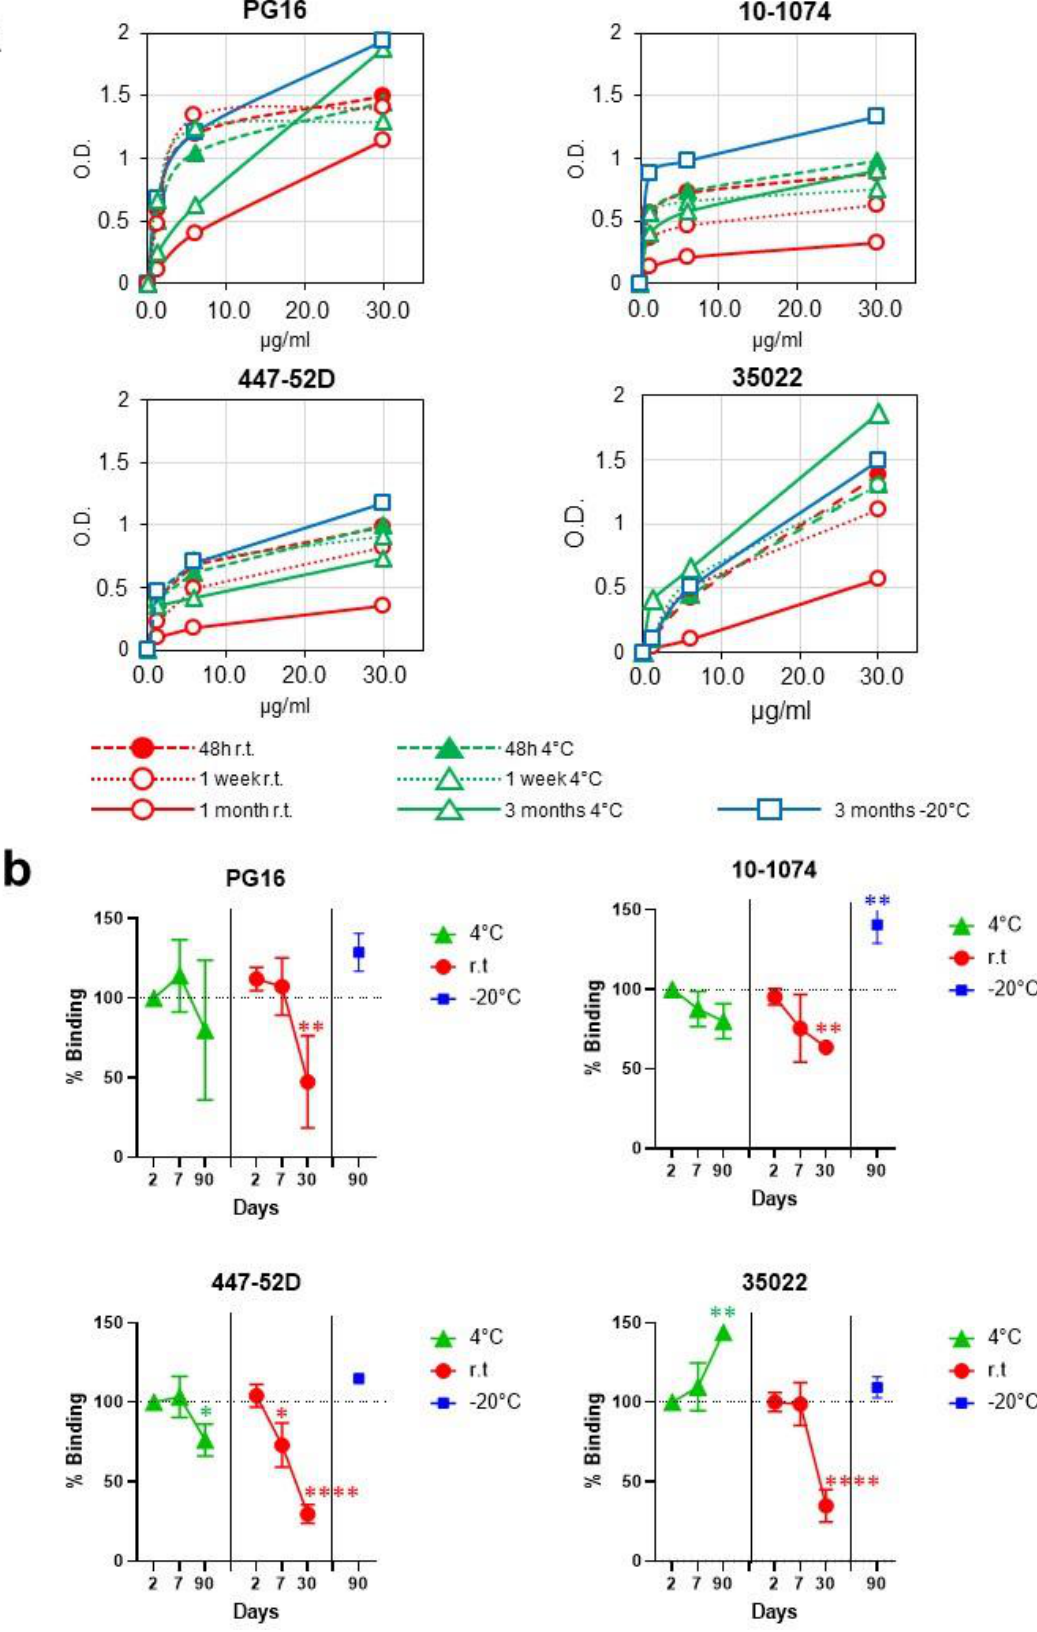
Figure 2. B-cell epitope preservation after storage at different temperatures. ( a ) Antigenicity of